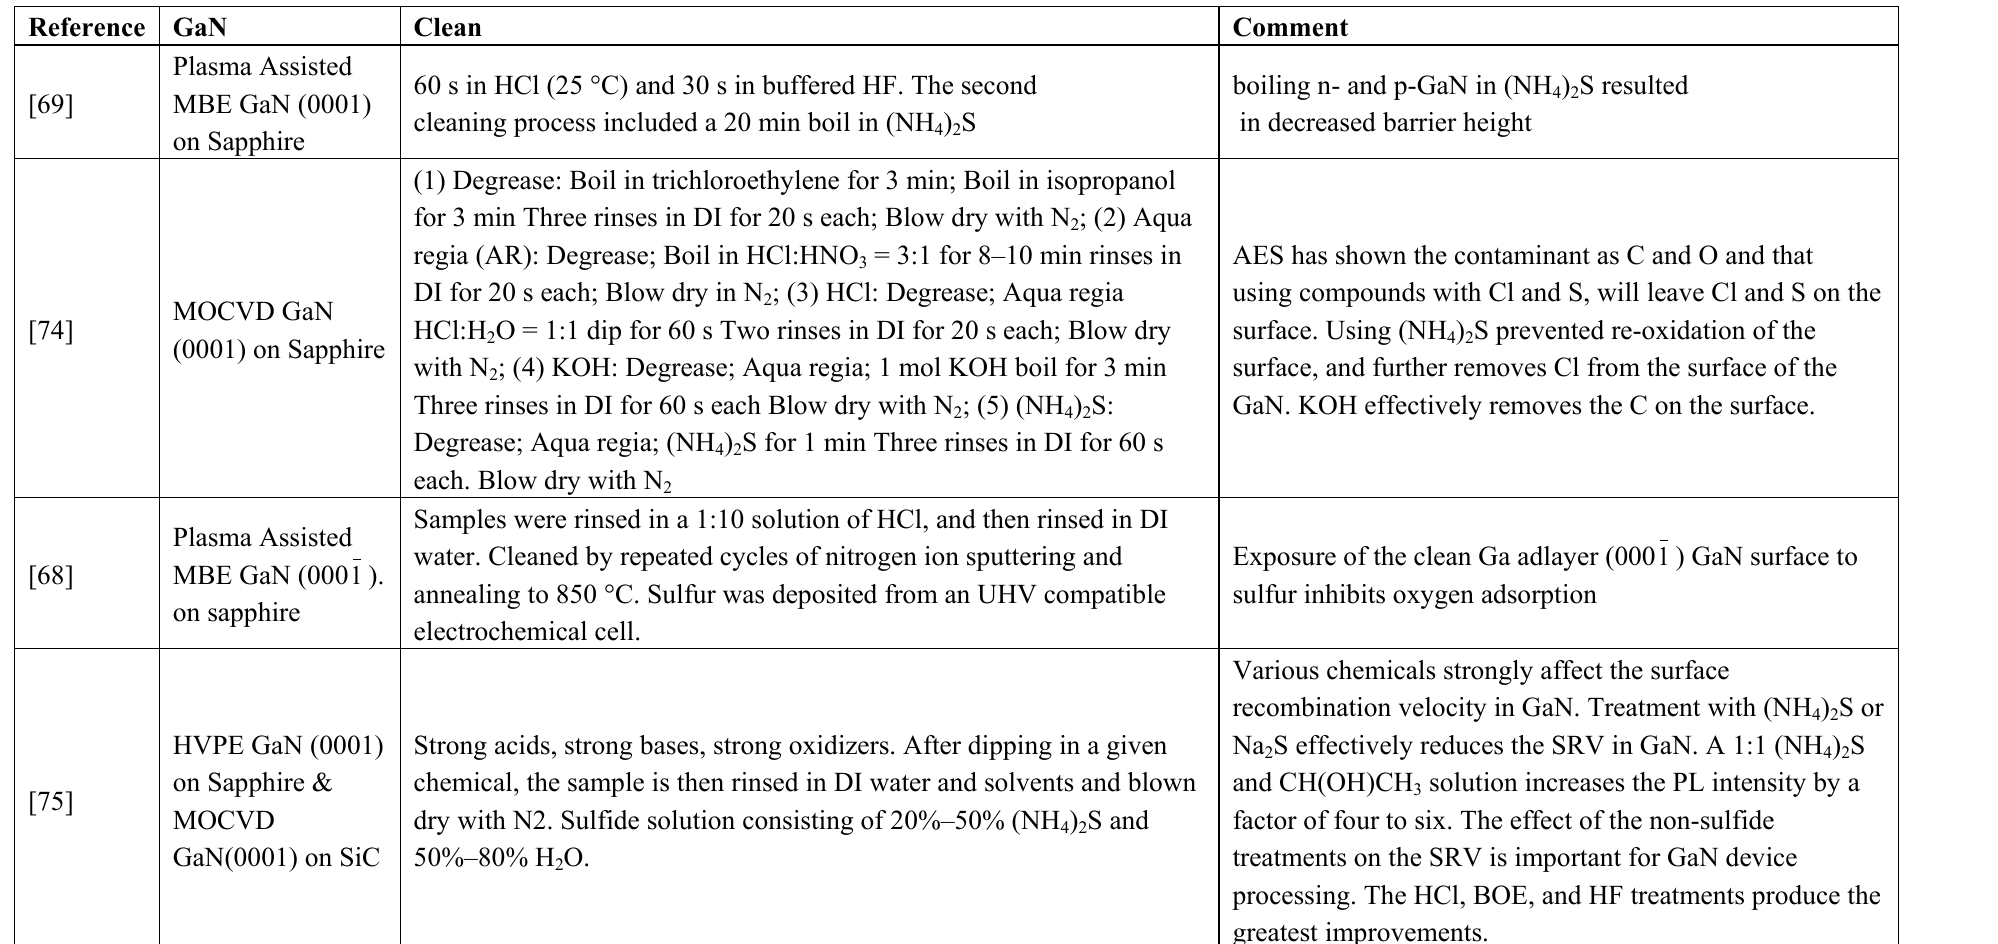
Table 2. More details on some of the cleaning procedures reviewed in this